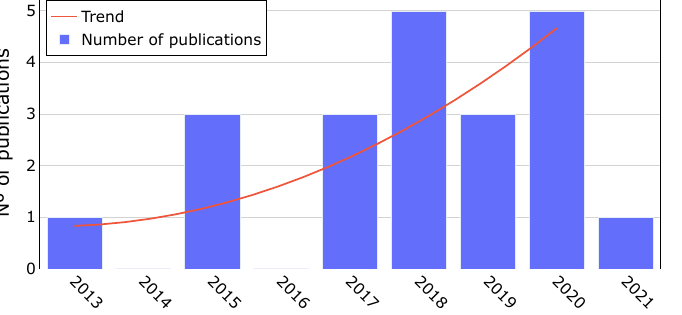
Figure 2. Publications’ distribution over the years between 2012 and 2022, related to KPI-based methodologies for WWTPs. No papers were found in the years 2012 and 2022 that fit the objectives of this review.